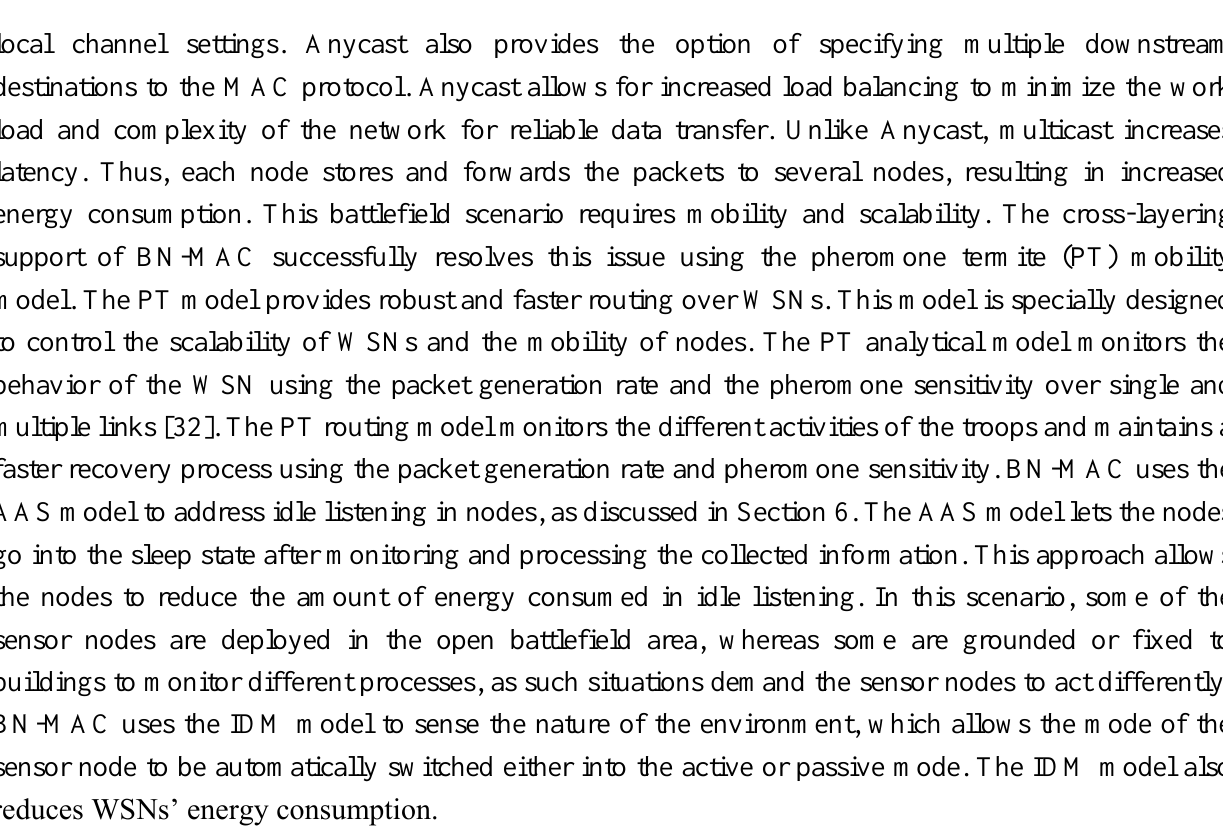
Figure 1. Proposed simulated